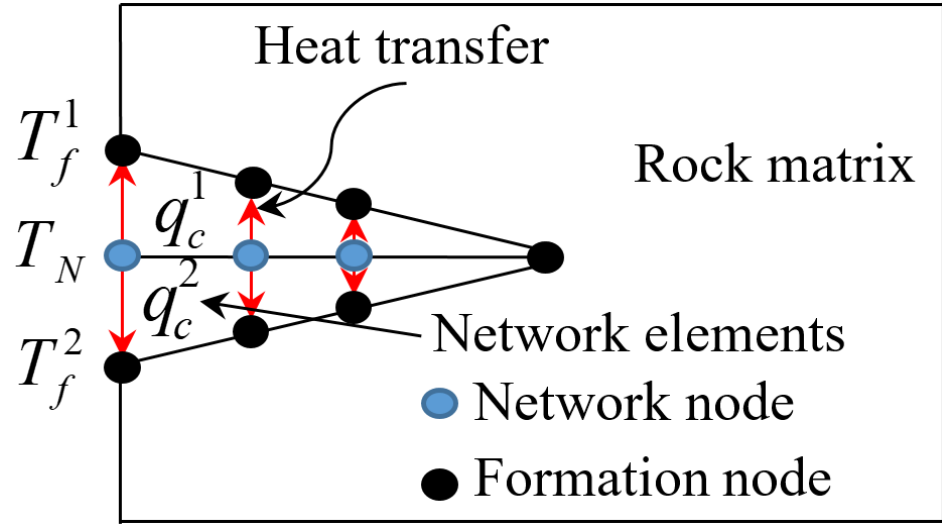
Figure 3. Heat transfer between finite element nodes in formation and network.